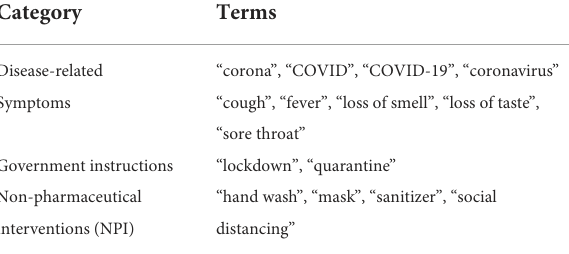
TABLE 1 Grouping of COVID-19 related GT search